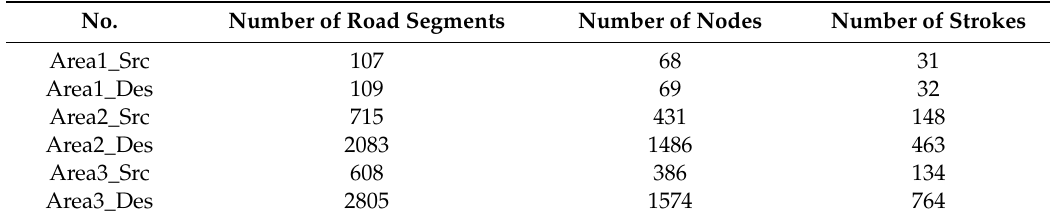
Table 2. Three pairs of road networks used for experiments.